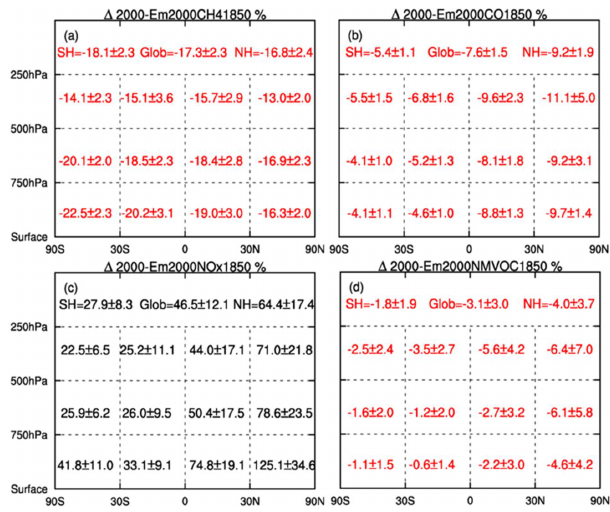
Fig. 7. Percent change in multi-model mean OH in 12 subdomains of the atmosphere for 2000 relative to attribution experiments: a) Em2000CH41850 (8 models), b) Em2000CO1850 (6 models), c) Em2000NOx1850 (6 models), d) Em2000NMVOC1850 (6 mod- els). OH increases are shown in black and decreases are in